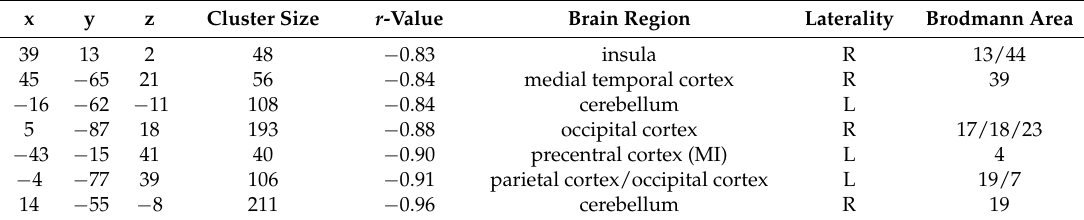
Table 3. Correlations between current pain ratings (VAS) and the differences in activation between pain-related vs. negative words in CBP